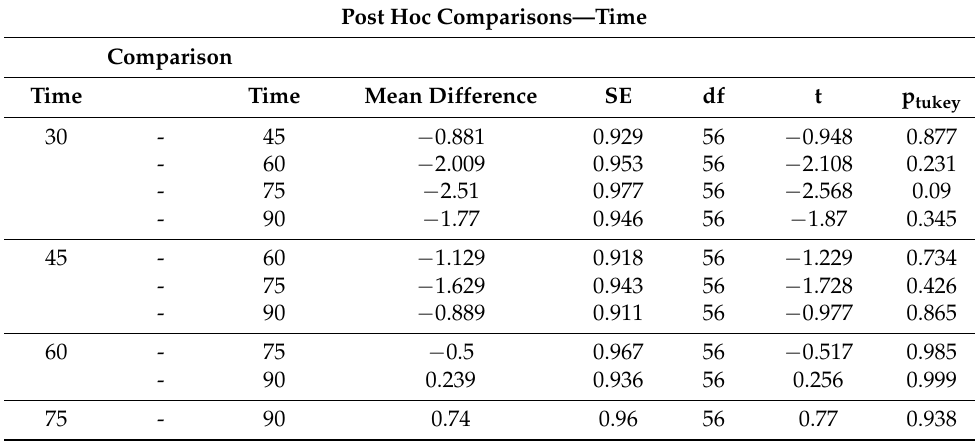
Table A3. Tukey test for time treatments in pectin yield extraction.